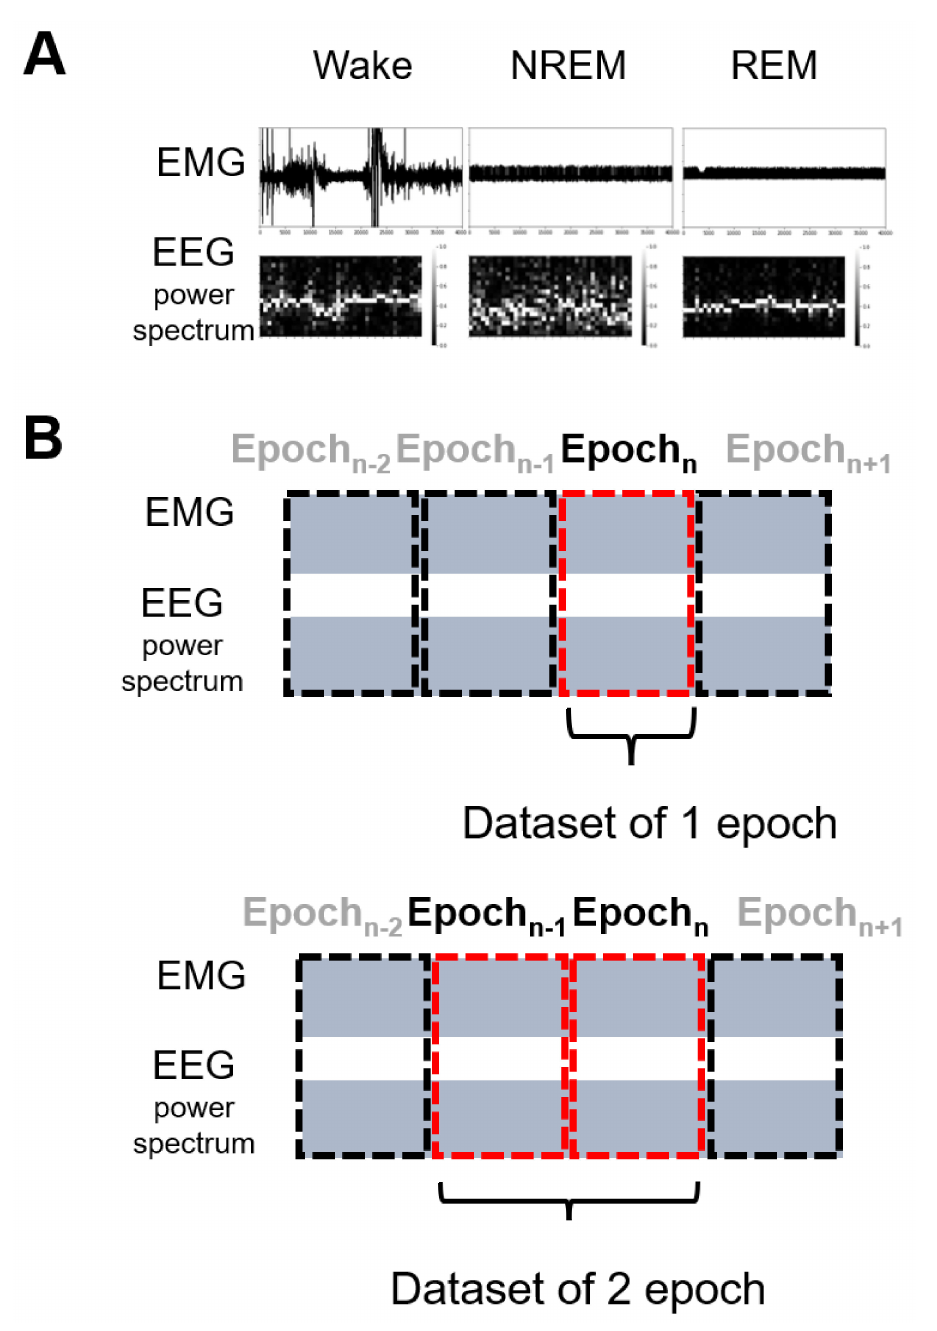
Figure 1. Image production for image-based machine learning. ( A ) Sample images of three sleep stages—wake, NREM, and REM. The upper part of the data image is the EMG. The vertical coordinate is fixed between all the images. The lower part is the heatmap of the EEG power spectrum (1–20 Hz) of 1 s bins. The brightness of the heatmap is normalized by Python’s scikit-learn library. ( B ) Schematic representation of 1- and 2-epoch data image generation. Images are labeled by the sleep stage and the 2-epoch image is classified according to the designation of the latter half of the 20-s